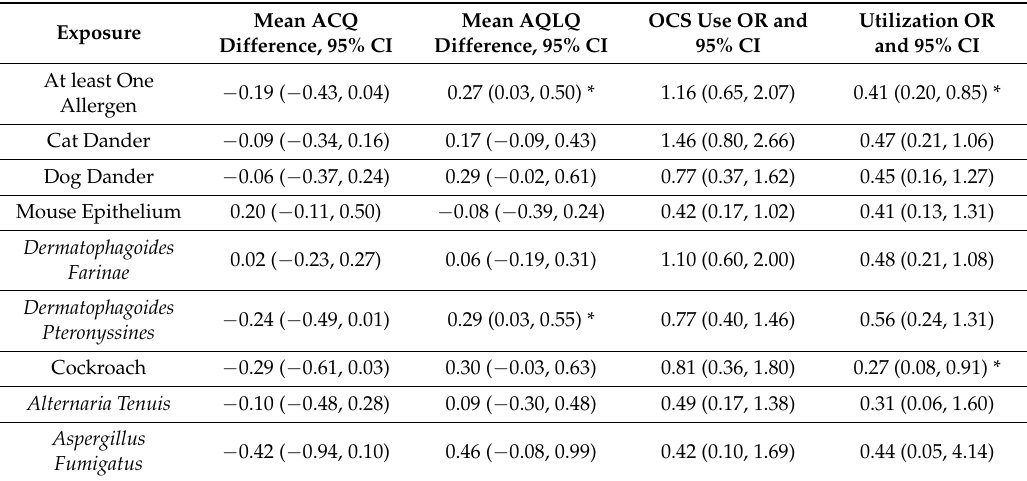
Table 4. Adjusted associations between sensitization to indoor allergens and asthma morbidity in World Trade Center rescue and recovery